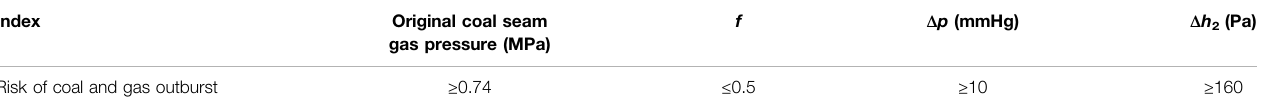
TABLE 4 | Critical value of coal seam outburst risk index.